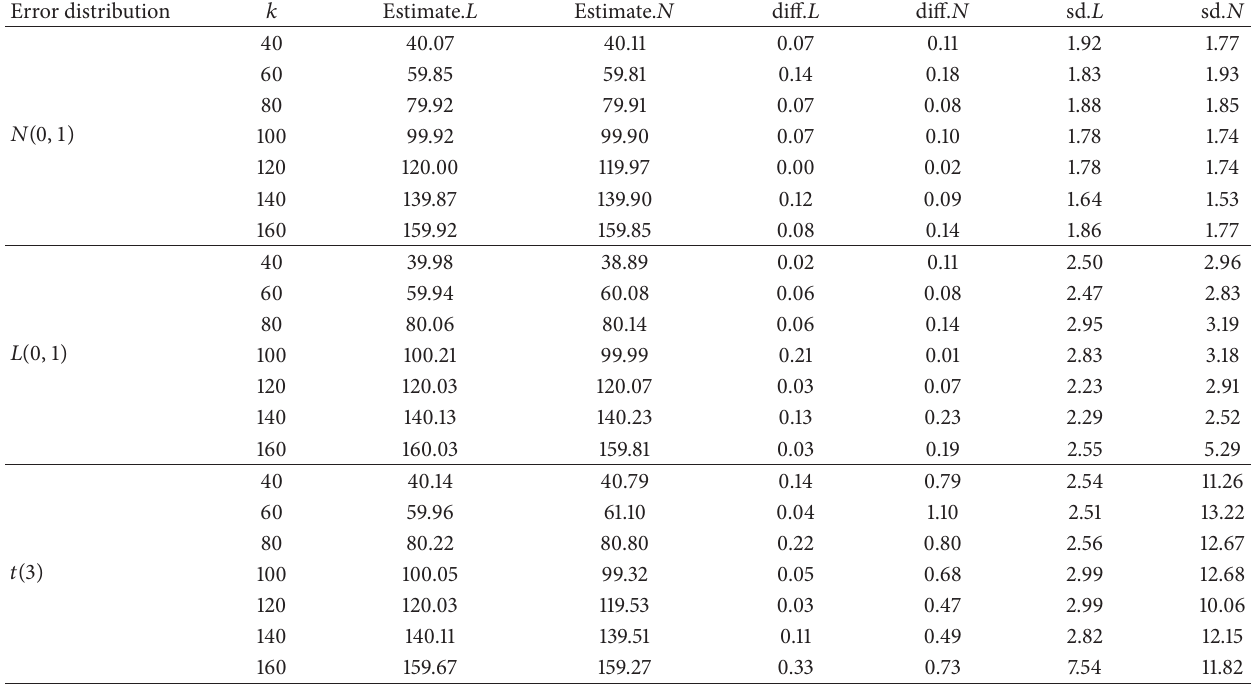
Table 1: Comparison of results for Laplace model and normal model based on 500 replications in Simulations 1–3. Error distribution